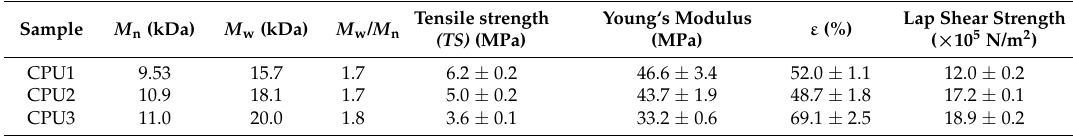
Table 1. Structure characteristics and mechanical properties of CPUs.